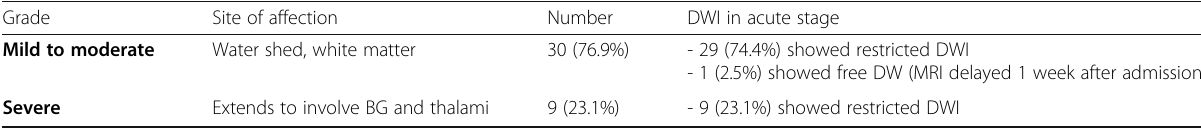
Table 3 Grades of HII and their DWI findings Grade